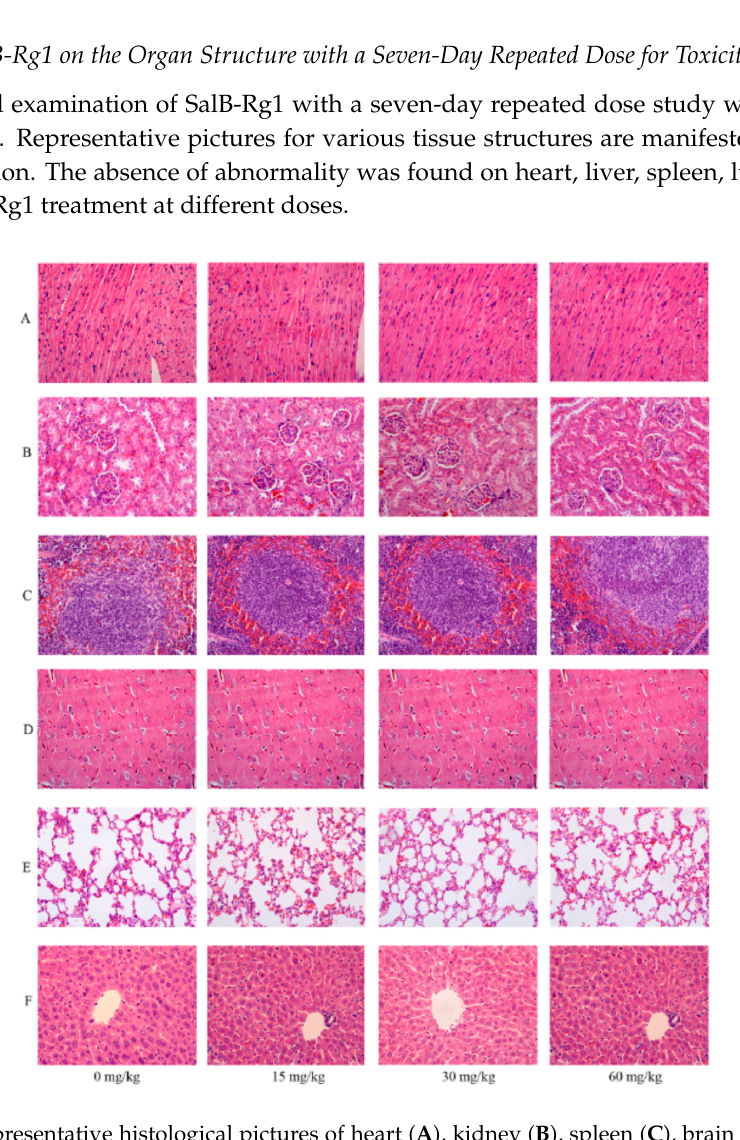
Figure 5. Representative histological pictures of heart ( A ), kidney ( B ), spleen ( C ), brain ( D ), lung ( E ) and liver ( F ) staining with H&E in the seven-day repeated toxicity study (magnification 400×). 2.10. Effects of SalB-Rg1 on Biochemical Parameters of the Seven-Day Repeated Dose for Toxicity Evaluation